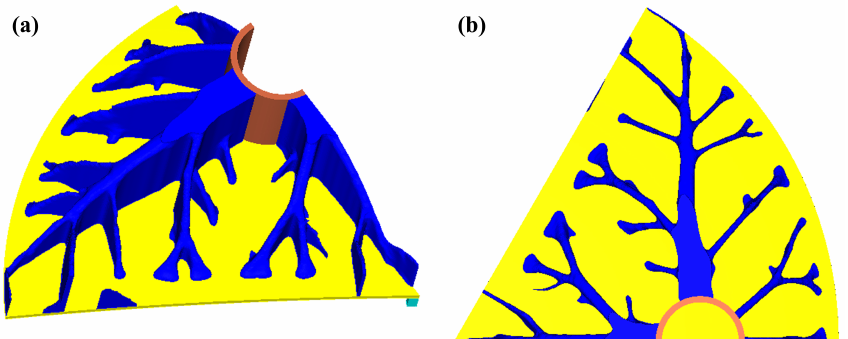
Figure 6. Topology optimization results when α = 0.17. ( a ) Three-dimensional stereogram. ( b ) Top